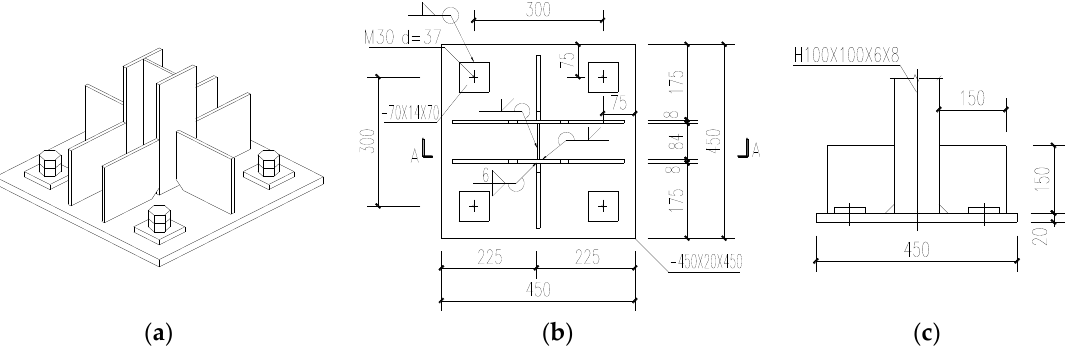
Figure 2. Detailed connections at the bottom of columns (unit: mm). ( a ) 3D; ( b ) plane; ( c ) section A – A.